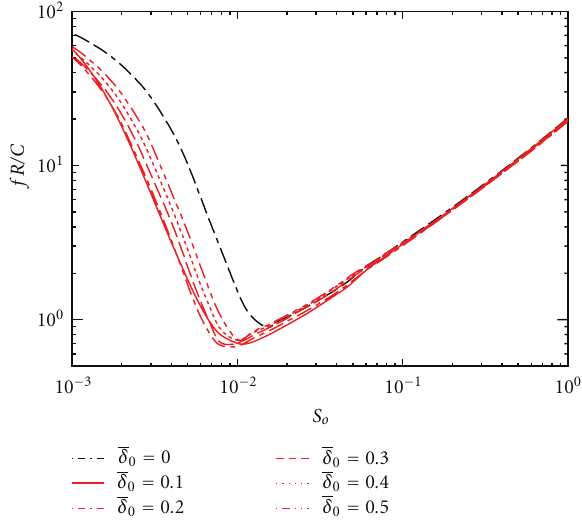
Figure 4: E ff ect of dent δ o on frictional coe ffi cient f R / C .